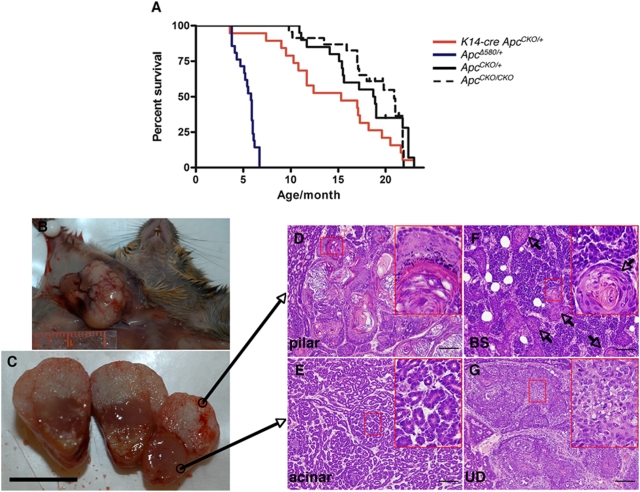
Mammary tumorigenesis in K14-cre; ApcCKO/+ female mice.(A) Survival Curve of K14-cre ApcCKO/+ mice. Kaplan-Meier survival plot of K14-cre; ApcCKO/+ (red solid line, n = 19), ApcΔ580/+ (blue solid line, n = 21), ApcCKO/CKO (broken line, n = 37) and ApcCKO/+ mice (solid line, n = 33). Germline Apc heterozygous (ApcΔ580/+) mice are predisposed to multiple intestinal tumorigenesis, but K14-cre driven Apc heterozygosity have decreased survival compared to the controls primarily due to predisposition to mammary tumors. (B, C) A mammary tumor (C) from a K14-cre; ApcCKO/+ female mouse (B) with grossly biphasic growth. Scale bar 1 cm. (D–G) K14-cre; ApcCKO/+ tumors show a spectrum of histological patterns from differentiated pilar (D), acinar (E), basosquamous (BS, F) to undifferentiated (UD, G), usually in combinations of these. Squamous metaplasia (arrows) is frequent in these tumors, showing transdifferentiation to epidermal and pilar structures. Insets are the area within respective red boxes at higher magnification. Scale bars 100 µm.